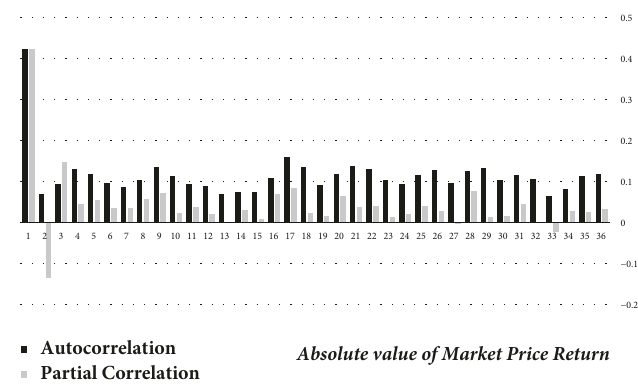
Figure 6: Absolute value of the return series.